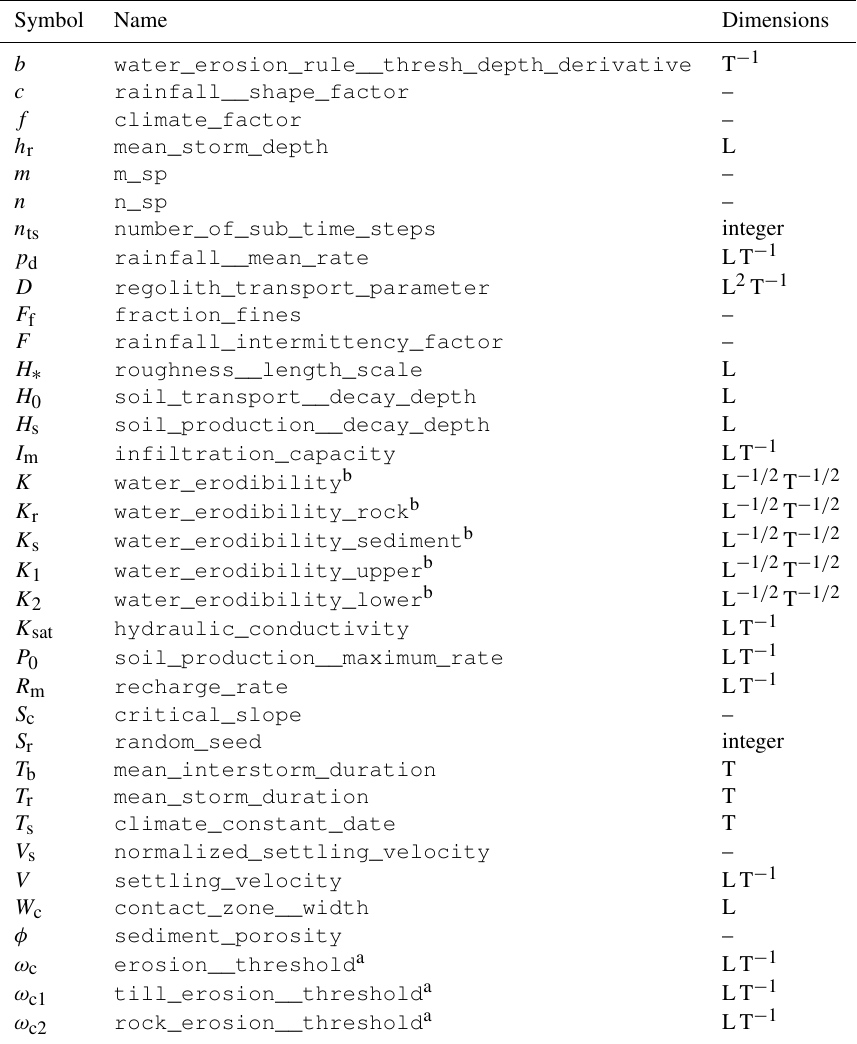
Table 4. Terrainbento parameter names and unit dimensions.